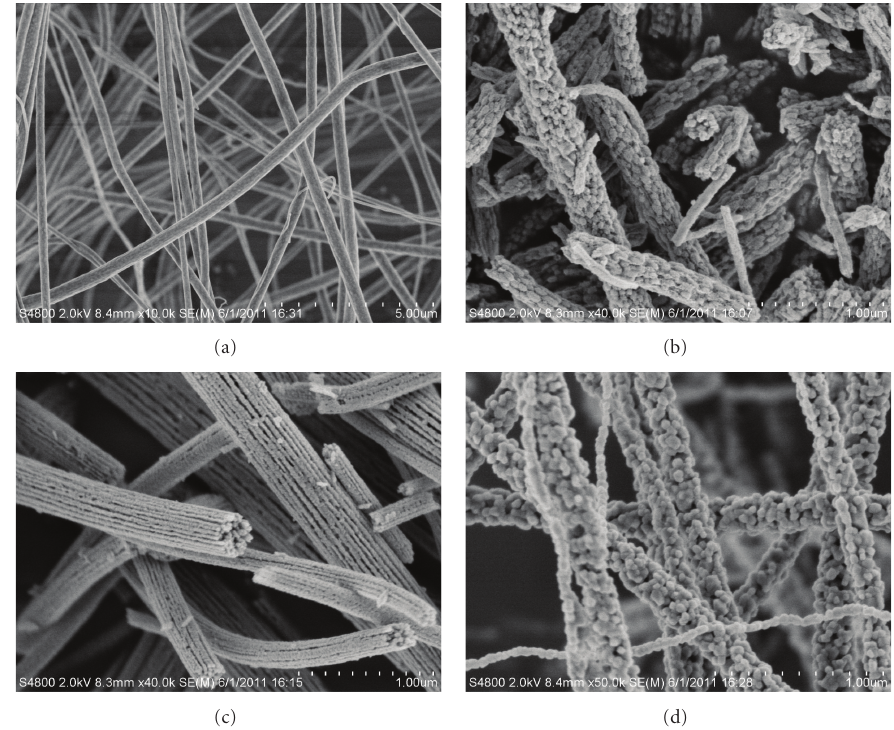
Figure 2: SEM images of the as-prepared (a) PVP/TBT composite nanofibers by electrospinning and thereof TiO 2 nanofibers sintered at (b) 500 ◦ C, (c) 600 ◦ C, and (d) 700 ◦ C for 3 hours in air,